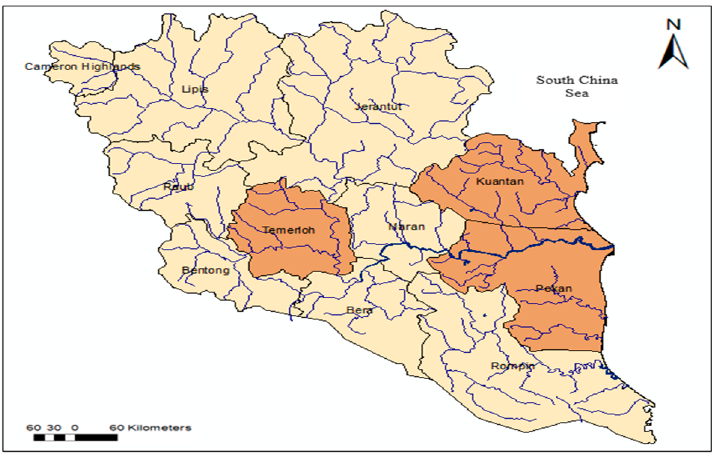
Figure 1. Map showing the districts of Temerloh, Pekan, and